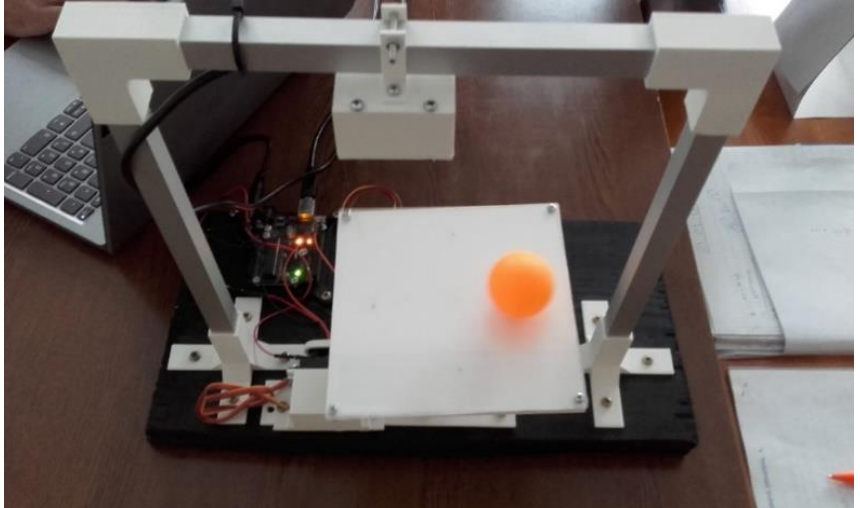
Figure 1. Laboratory educational BPS prototype in action.